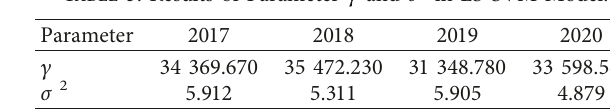
Table 5: Results of Parameter c and σ 2 in LS-SVM Model.